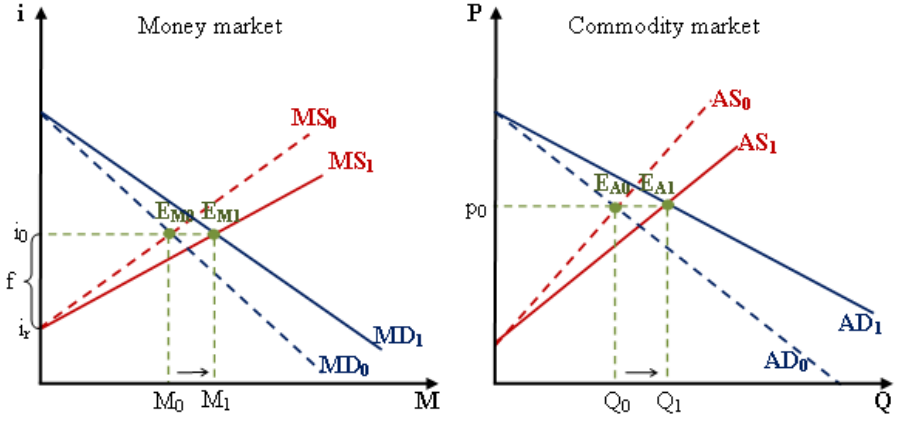
Figure 8. The sticky-price equilibrium economy.